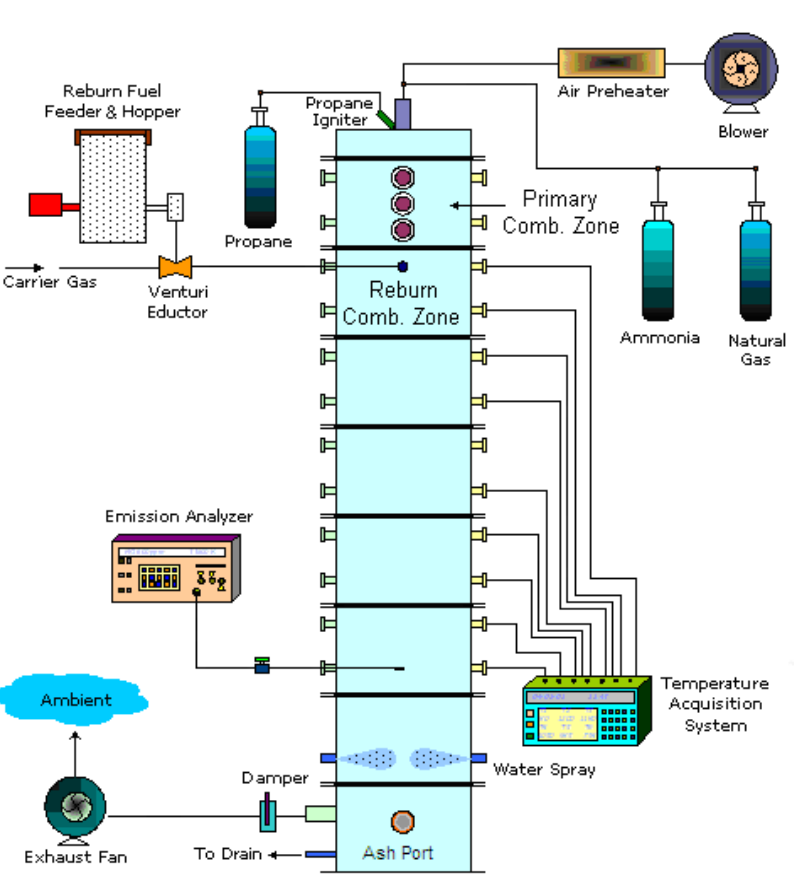
Energies 2021 , 14 , x FOR PEER REVIEW 9 of 27 Figure 2. A schematic of the bench-scale (30 kW or 100,000 BTU/h) down-fired boiler burner facility.